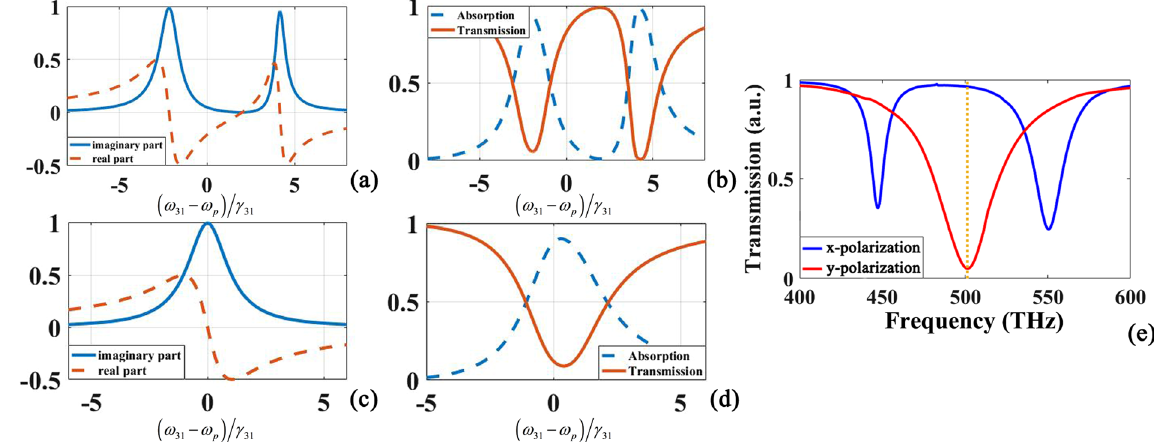
Figure 2. Transmission contrast between EIT atomic theory [( a – d )] and simulation results ( e ). The red line in ( b ) and ( d ) shows the transmission calculated from linear susceptibility and they are analogies of different polarization incident light responses (blue line and red line) in ( e )